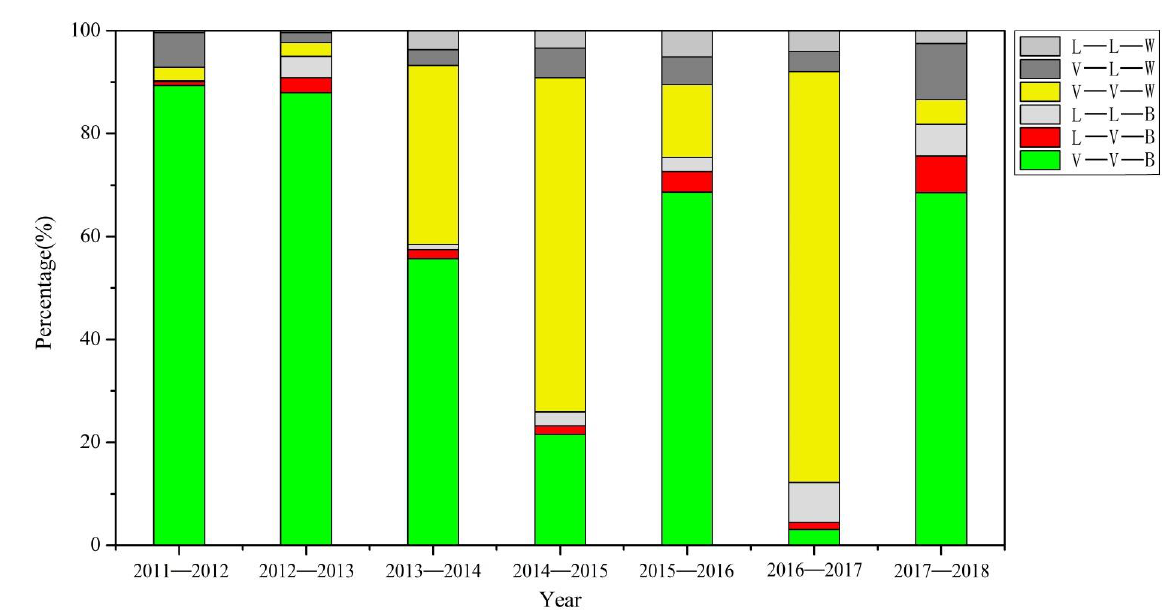
Figure 9. Percentage of different land type changes in two adjacent years from 2011 to 2018 in the study region.